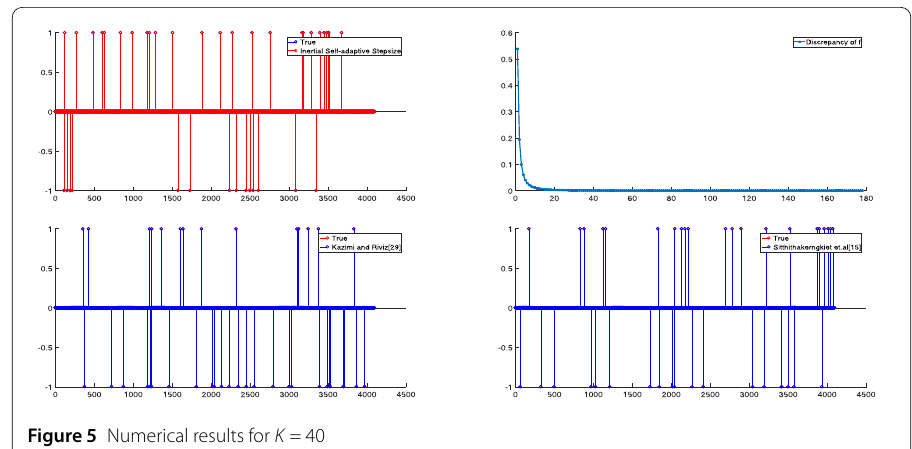
Figure 5 Numerical results for K =